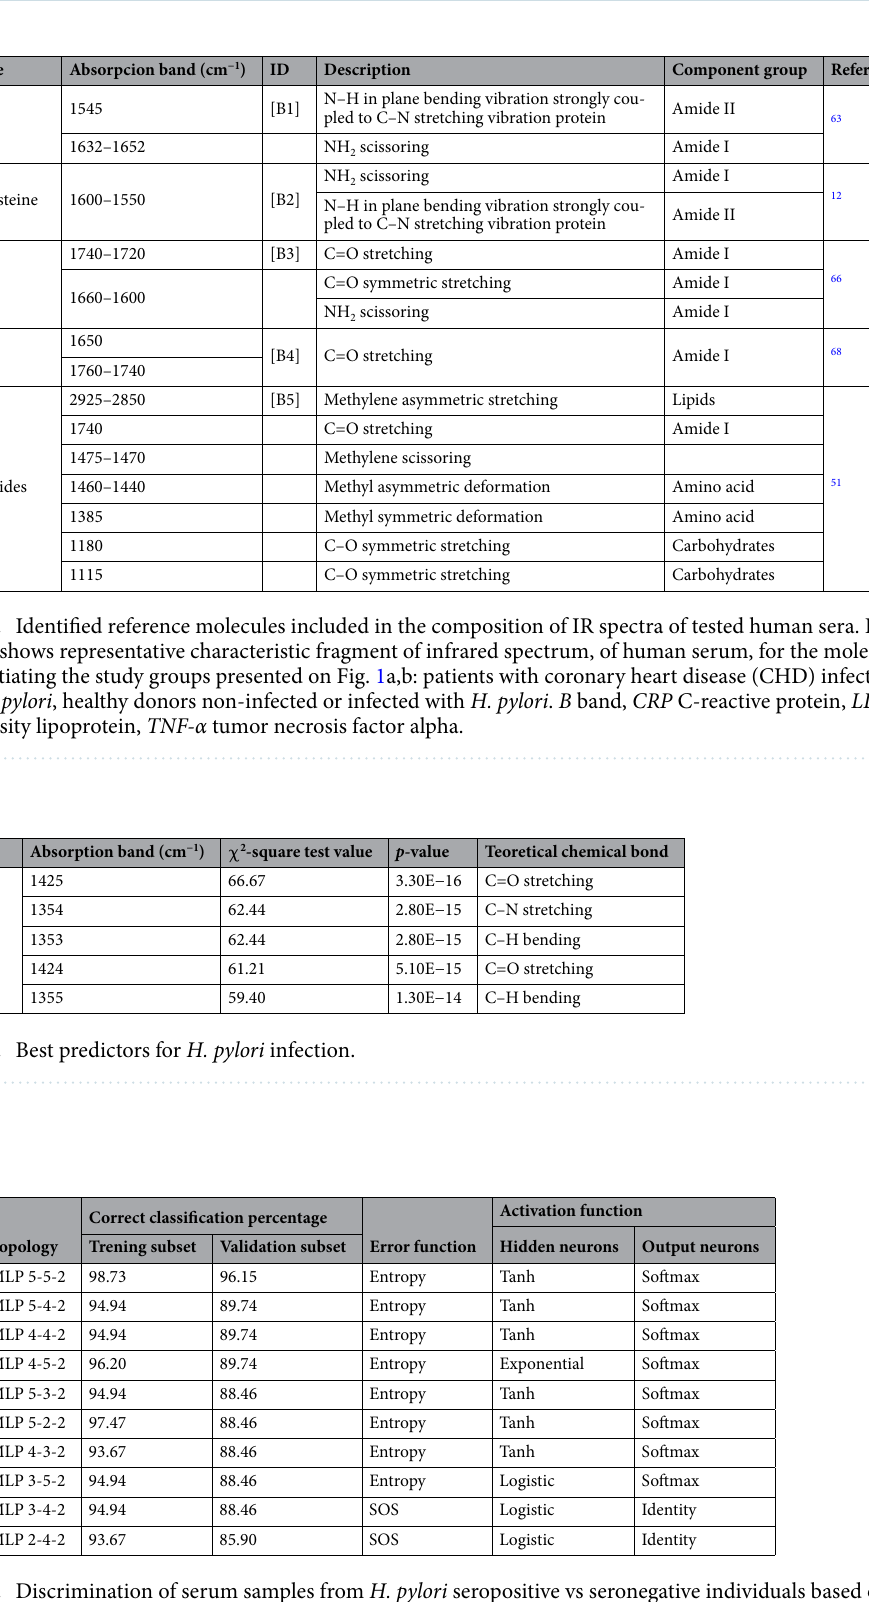
Table 4. Discrimination of serum samples from H. pylori seropositive vs seronegative individuals based on IR spectra and artificial neural